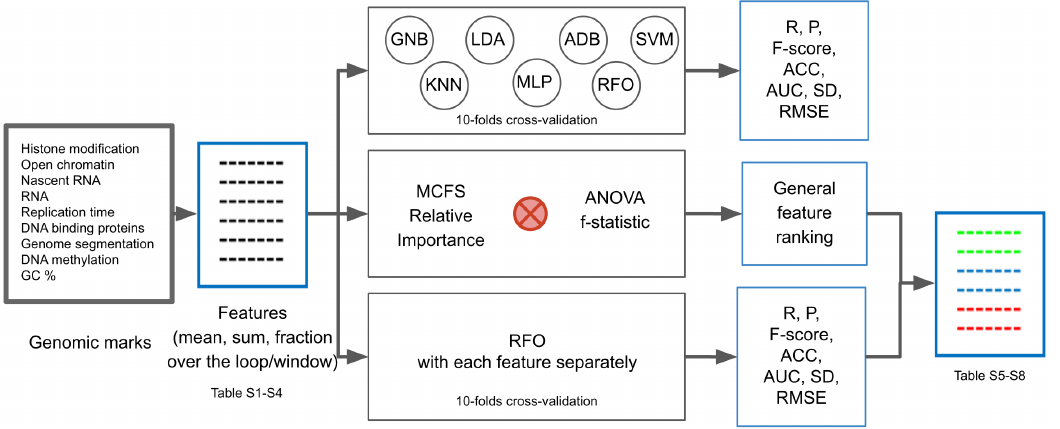
Figure 1. Feature evaluation